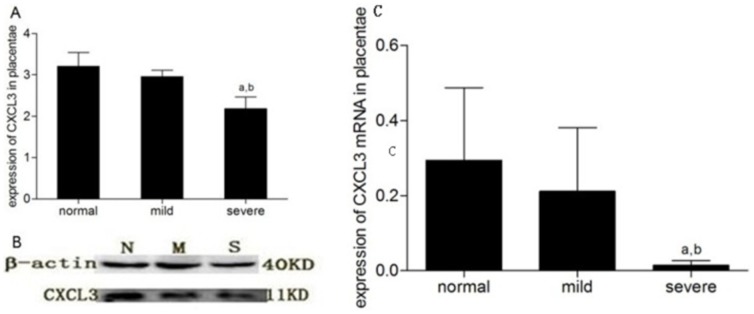
Placenta expression of CXCL3 and CXCL3-mRNA in normal pregnant women, mild preeclamptic pregnant women and severe preeclamptic pregnant women.A: Placenta CXCL3 was detected by western blotting (n = 6), Bar: mean; Whisker: standard deviation. a: p<0.01, versus normal pregnant women; b: p<0.01, versus mild pregnant women. B: N: normal; M: mild; S: severe. The experiment shown is representative of 1 of 6 performed. C: CXCL3-mRNA in each group (n = 12). Bar: mean; Whisker: standard deviation. a: p<0.05, versus normal pregnant women; b:p<0.05 versus mild pregnant women.